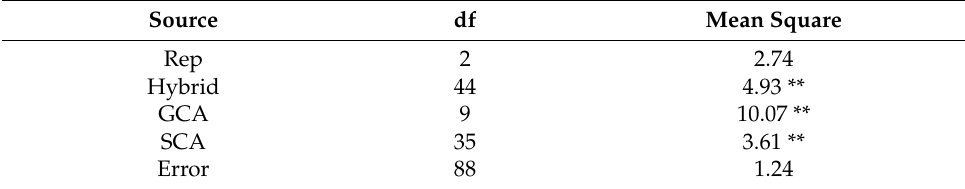
Table 6. Diallel analysis of variance for yield in